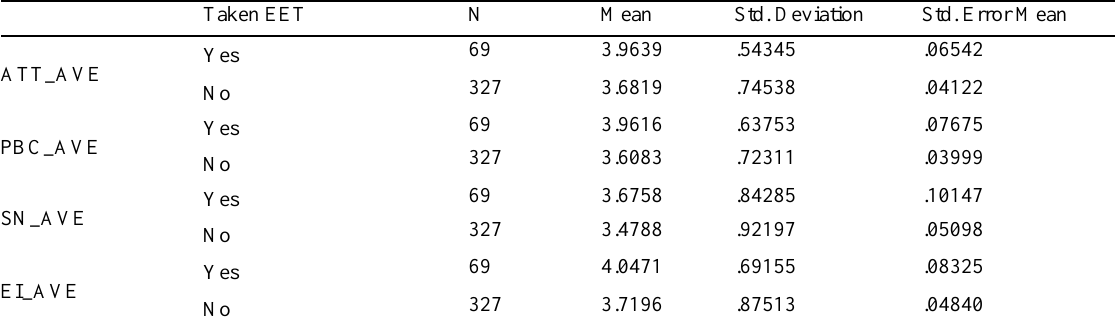
Table 10: Statistics on Student and Graduate IEC due to Exposure to Extra Entrepreneurial Training Taken